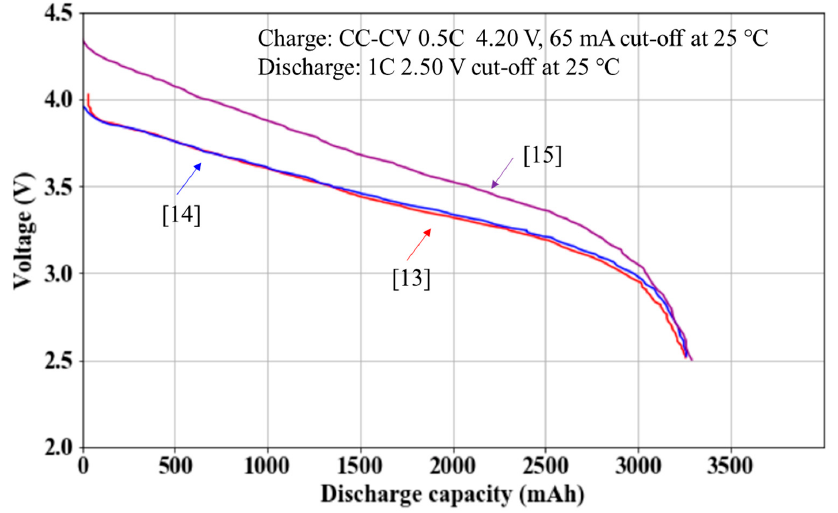
Figure 4. Observed inconsistent discharge characteristics at 25 ℃ , 1C from different sources for Panasonic NCR18650B cells.